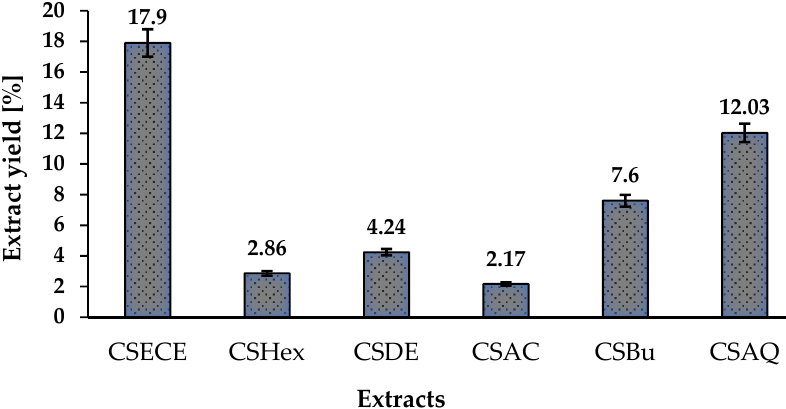
Figure 1. The yield of different extracts of Capparis spinosa L. leaves. CSECE: crude extract. The fractions: CSHex: hexane, CSDE: diethyl ether, CSAC: ethyl Acetate, CSBu: n-Butanol, CSAQ: aqueous. The extraction yields by fractionation of the raw extract of leaves of Capparis spinosa